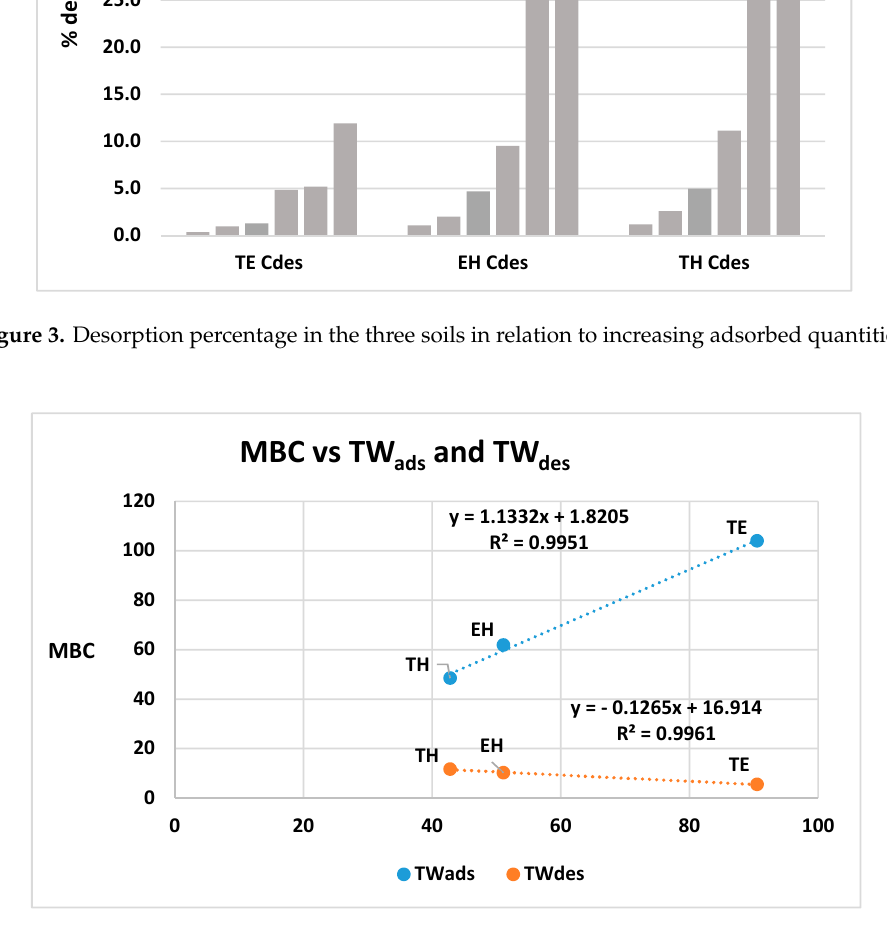
Figure 4. Trend of Maximum Buffer Capacity (MBC) vs. total tungstate adsorbed (TW ads ) and desorbed (TW des ) amounts.